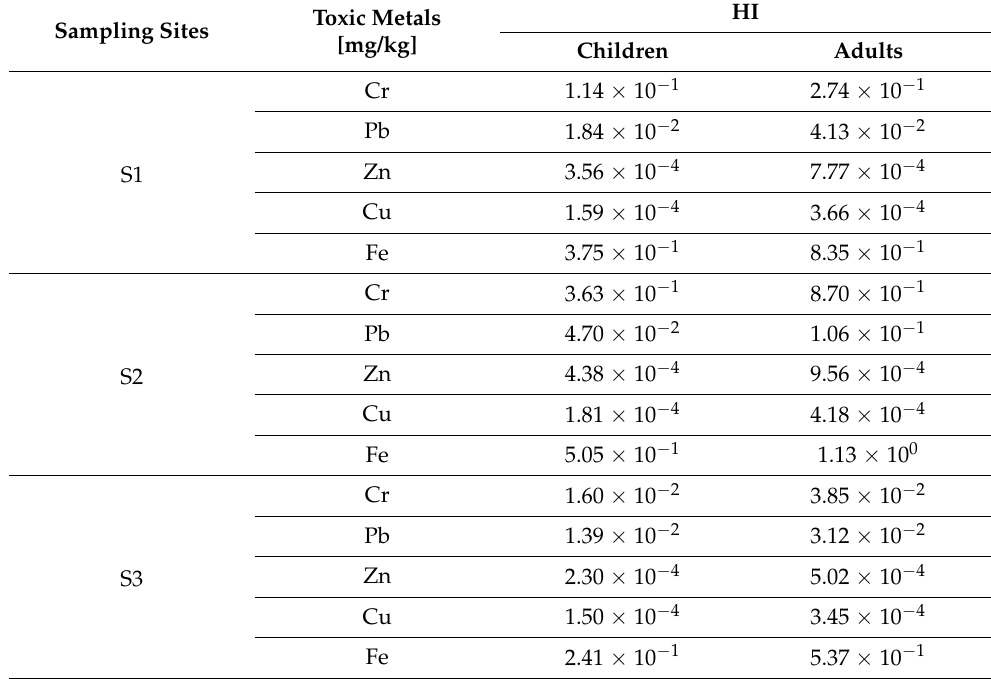
Table 10. HI for the sediments at all the studied sites: S1 “Bł˛ekitna Laguna”, S2 “Huta”, and S3 “Mała Szwecja”